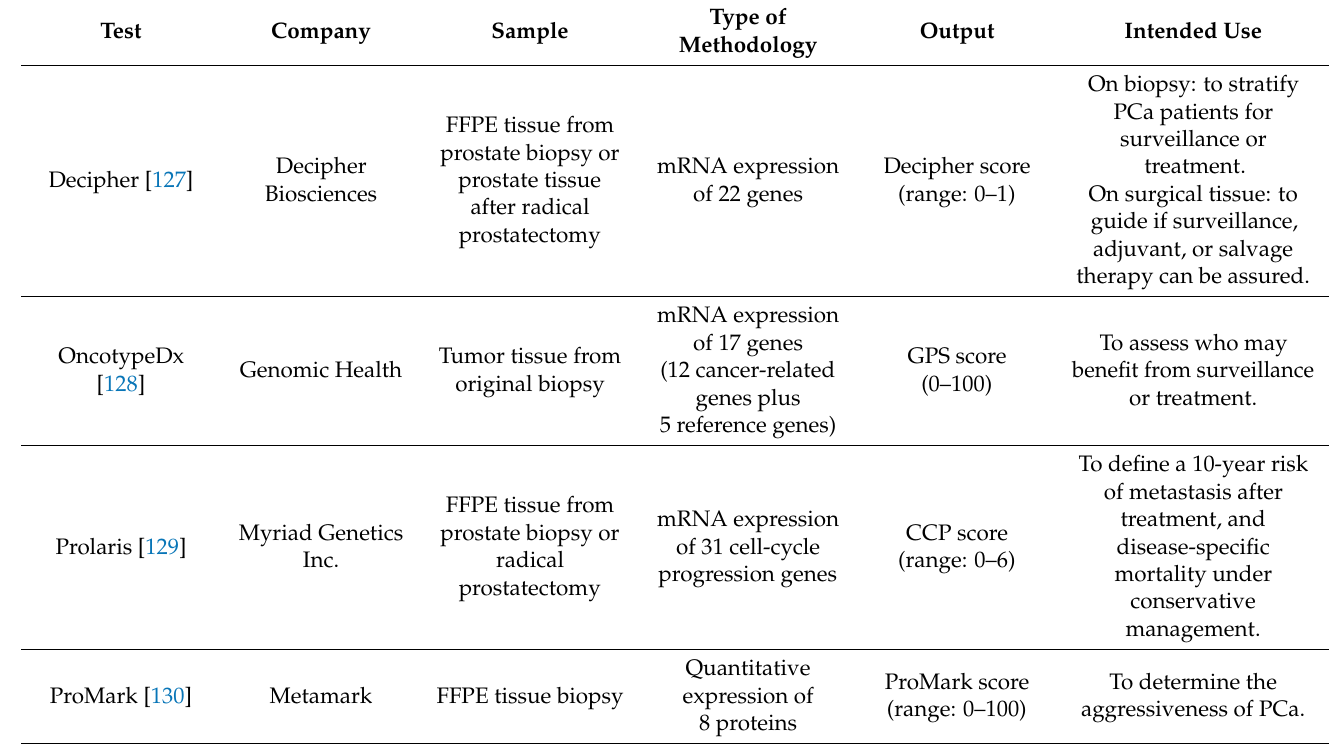
Table 2. Tissue-based molecular tests in prostate